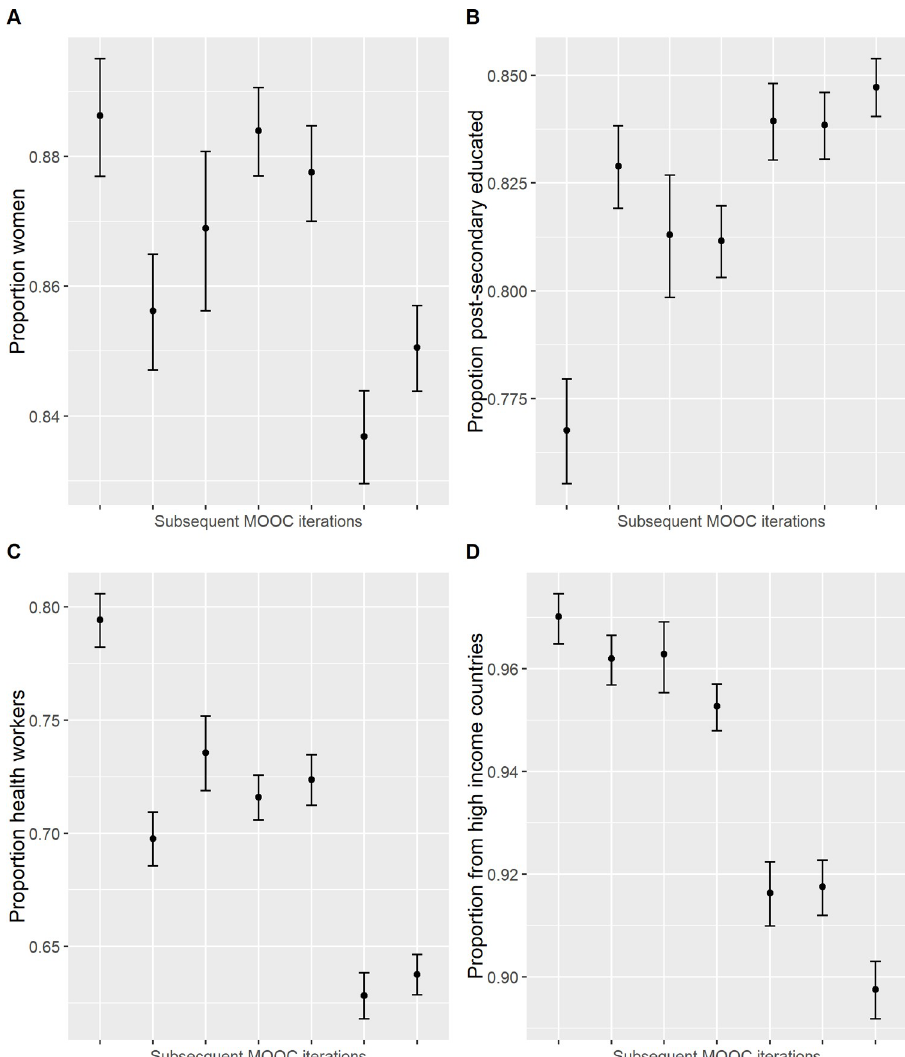
Fig 2. Proportions of participants who were female (A), had completed post-secondary education (B), worked in health care and social assistance sectors (C), and lived in high-income countries (D) in each of the seven Preventing Dementia MOOC iterations (year-month). Increasing representation over time is demonstrated for men (A), those with post-secondary qualifications (B), those working outside health care and social assistance, and those in low- and middle-income countries